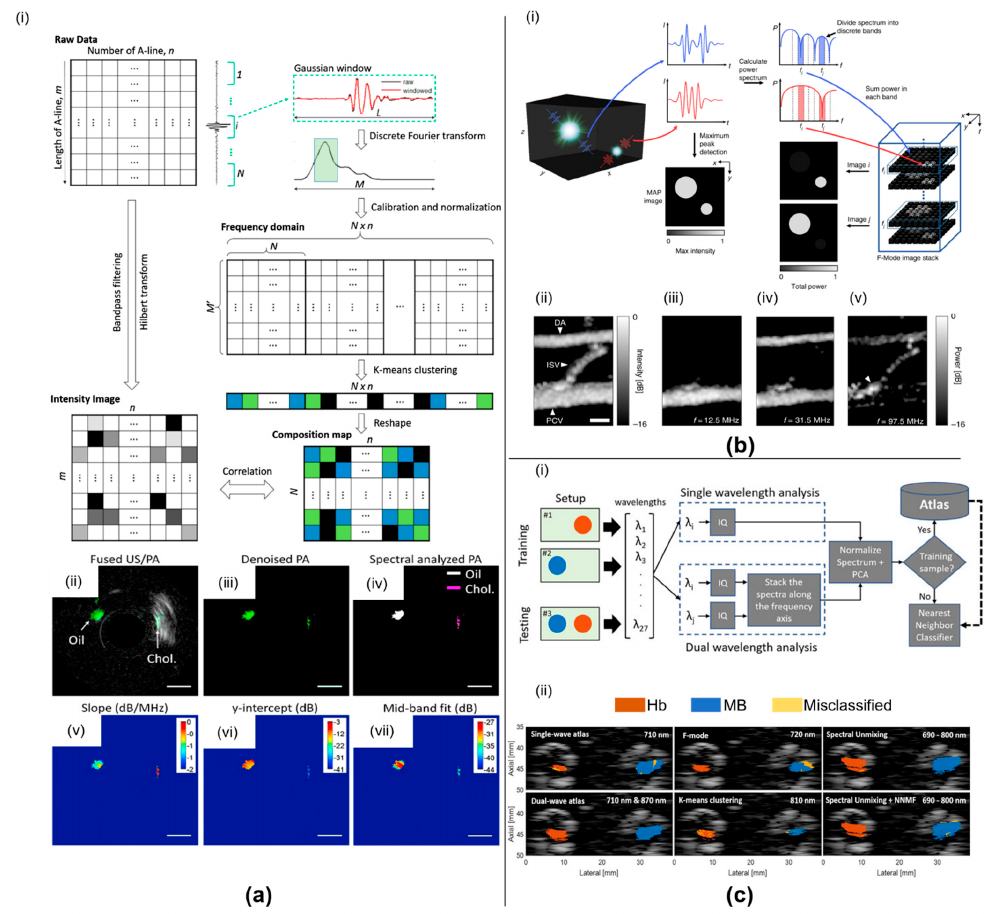
Figure 3. ( a ) Spectral analysis workload of photoacoustic signal; (i) the depth m and the scanning length n; by cropping Gaussian window L, the frequency domain after calibration was presented using the tailored spectrum of Gaussian matrix; using a shorter K-means clustering, the composition map was applied to B-scan; (ii) the PAI (gray) and derived composition spectral map (green); (iii) PAI based on signal thresholding; (iv) reconstructed composition map, marked by cholesterol (purple) and cholesteryl ester (white); (from v to vii) spectral maps showing slope, y-intercept, and mid-band fit. Reproduced with permission from Cao et al. [84]; published by Elsevier, 2017; ( b ) the overview of the F-Mode technique; (i) two phantoms were stimulated and divided into discrete frequency spectra; the reconstruction was segmented in the MAP image stack; (ii) the application of F-mode for scale-specific live-visualization of zebrafish vessels contains: the dorsal aorta (DA)/intersegmental vessel (ISV)/posterior cardinal vein (PCV) (iii) only PCV; (iv) removed ISV; (v) small ISV hidden under PCV. Reproduced with permission from Moore et al. [85]; published by Nature , 2019; ( c ) (i) overview of the differentiate photoacoustic signal sources by proposed method, (ii) separated ROIs for methylene blue (MB) and hemoglobin (Hb); (ii) ROIs of MB and Hb using different approaches. Reproduced with permission from Gonzalez et al. [83]; published by Frontiers , 2021.